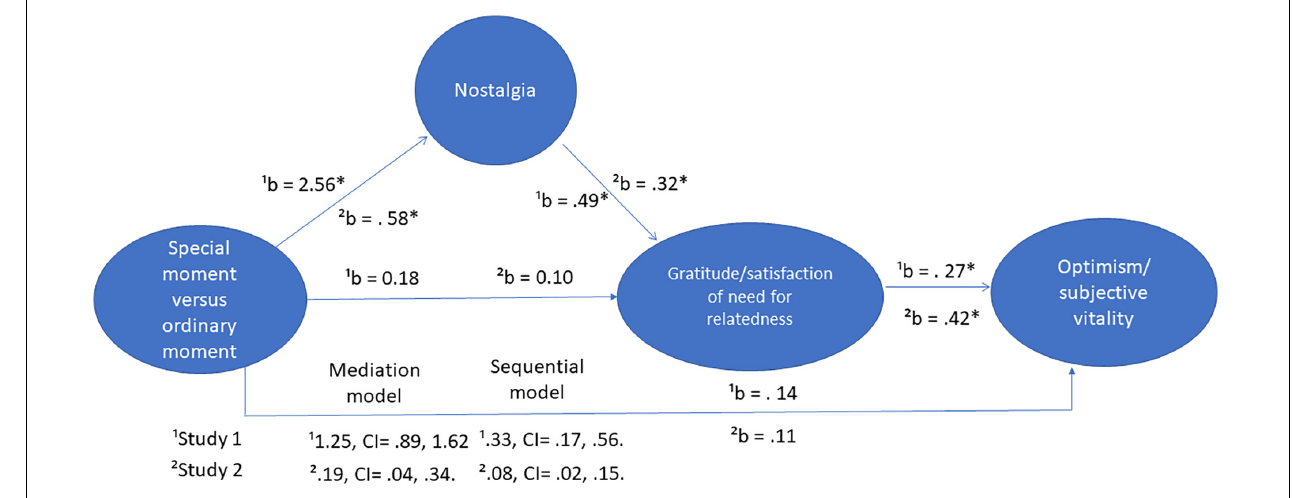
FIGURE 2 | Summary of results.